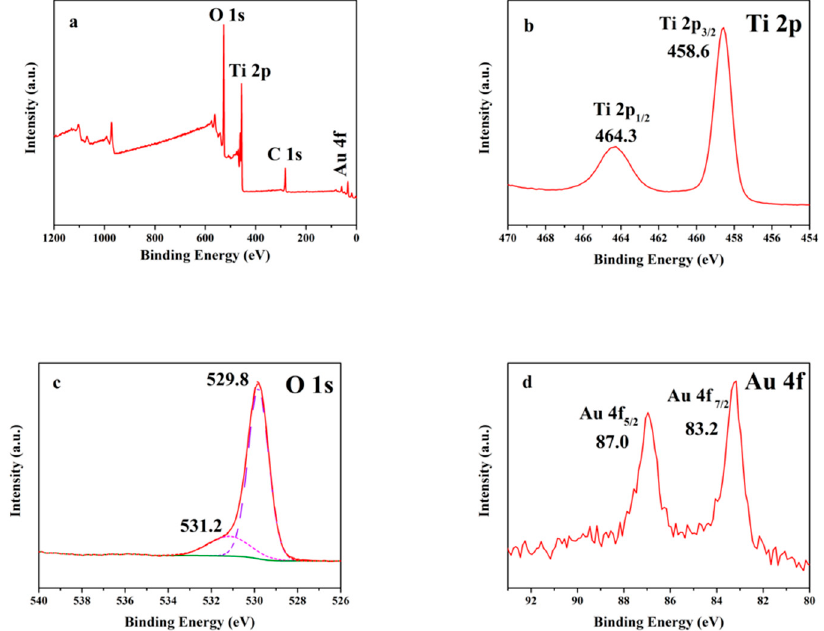
Figure 3. ( a ) XPS full spectrum of 0.5 wt.% Au/TiO 2 NTs, and high-resolution spectrum for ( b ) O 1s; ( c ) Ti 2p; ( d ) Au 4f.